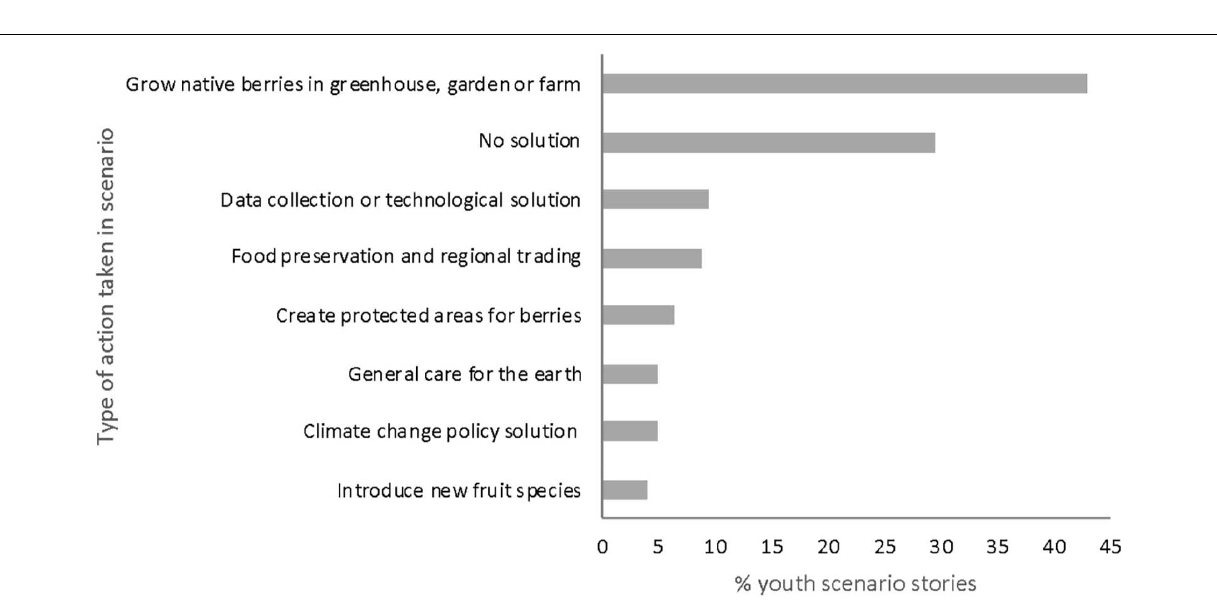
Frontiers in Ecology and Evolution |